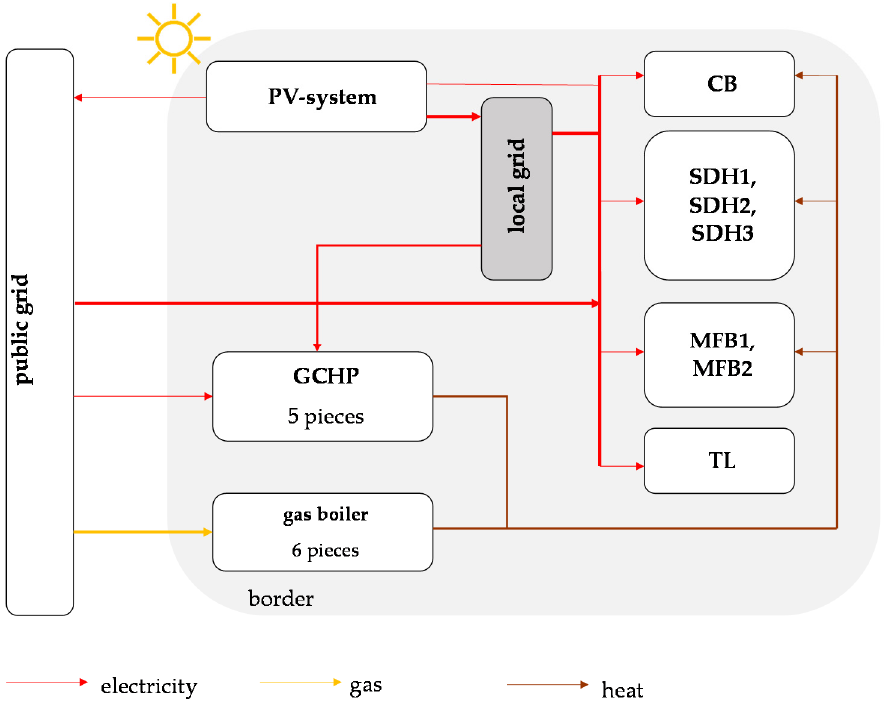
Figure 2. Overview of the cost-optimized scenario of the neighborhood under consideration. The grey area delimits the observation area. The relevant technologies for electricity and heat supply are shown. The directions of the arrows show the flow direction. The local grid symbolizes the electricity exchange between buildings. The abbreviations stand for the individual buildings: Semi-detached house (SDH), commercial building (CB), multi-family building (MFB), traffic lights and streetlights (TL). The individual buildings are each supplied by a gas boiler and by a GCHP (ground coupled heat pump). Compared to the CO 2 -optimized scenario, there is no heating network in the neighborhood.